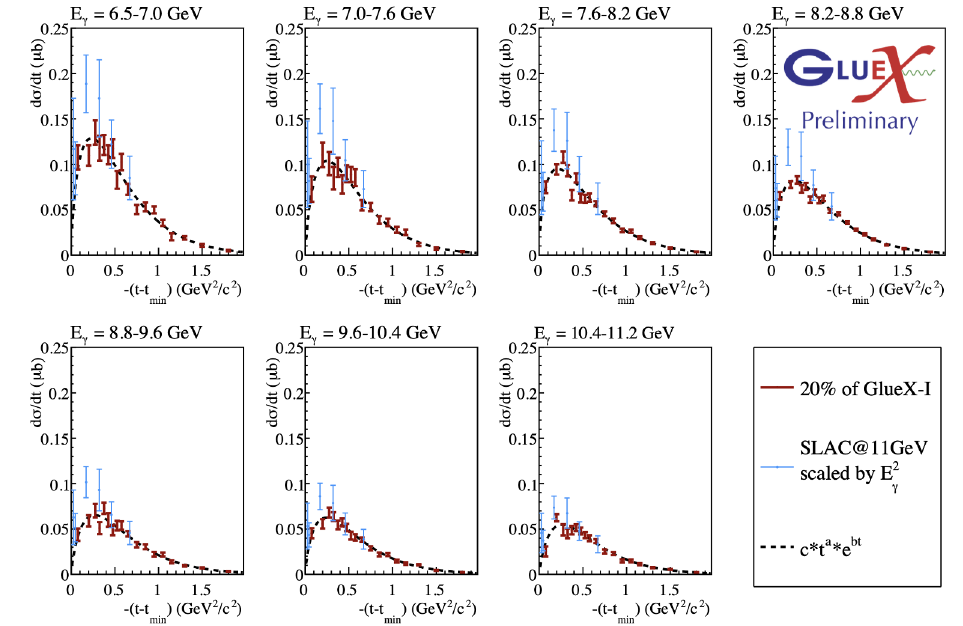
Figure 5. Preliminary total cross-section results are show in red. The green data at low energies comes from the CLAS experiment [11] the data point at 11GeV is from SLAC [10]. The black dashed curve is a phenomenological fit of the form c ∗ E 2 a − 2 to the CLAS γ and SLAC data. Our preliminary data, which was not fitted, agrees well with the black